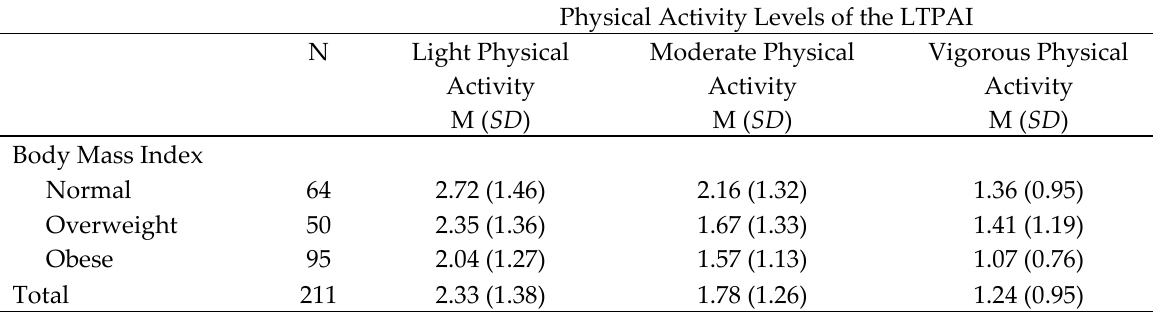
Table 2. Means and Standard Deviations of Physical Activity Levels of the LTPAI by Body Mass